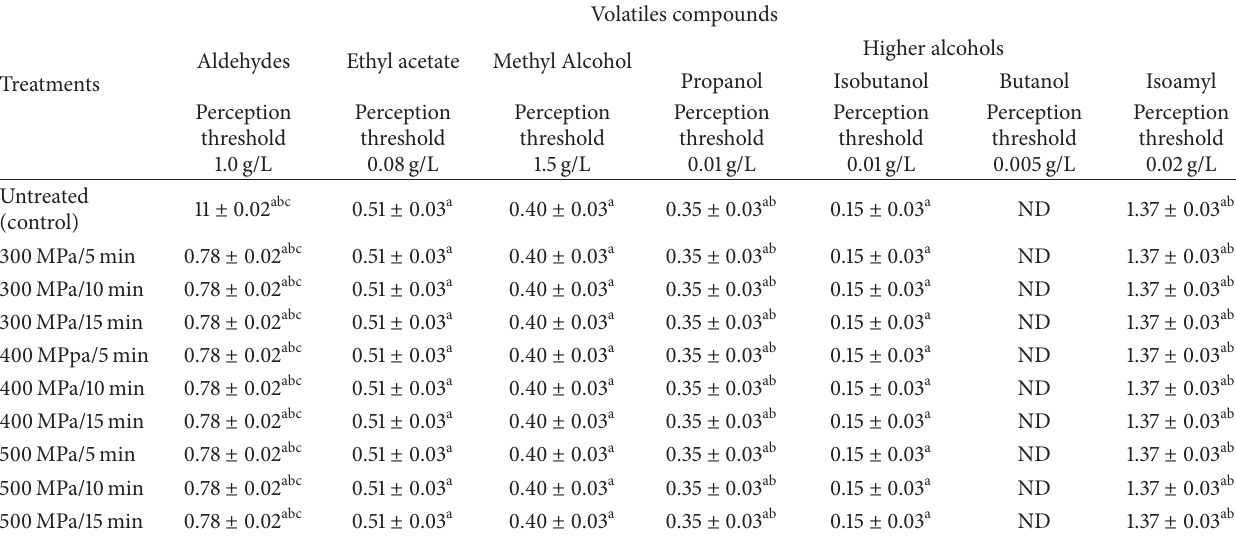
Table 6: Effect of HHP on volatile compound content of white wine (ND = not